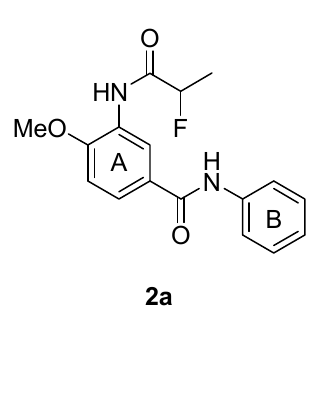
Figure 1. The structure of compound 2a